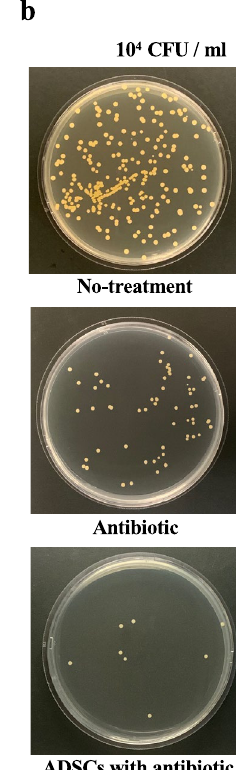
Figure 5. CFU assay. ( a ) Antibacterial activity determined using the spread plate method for implants. ( b ) Photograph of a tryptic soy broth agar plate of each group. All statistical analyses were performed using Welch ANOVA followed by Tukey HSD post-test (n = 6 rats per group). Data are reported as the median ± interquartile range. *p < 0.05. CFU colony-forming unit, ADSC adipose-derived mesenchymal stem cell.